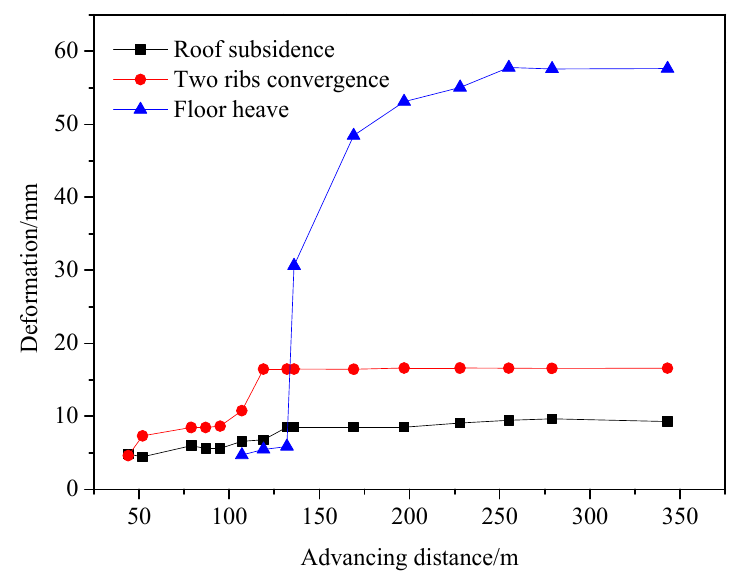
Figure 18. Deformation variation of the roadway with roadway excavating.